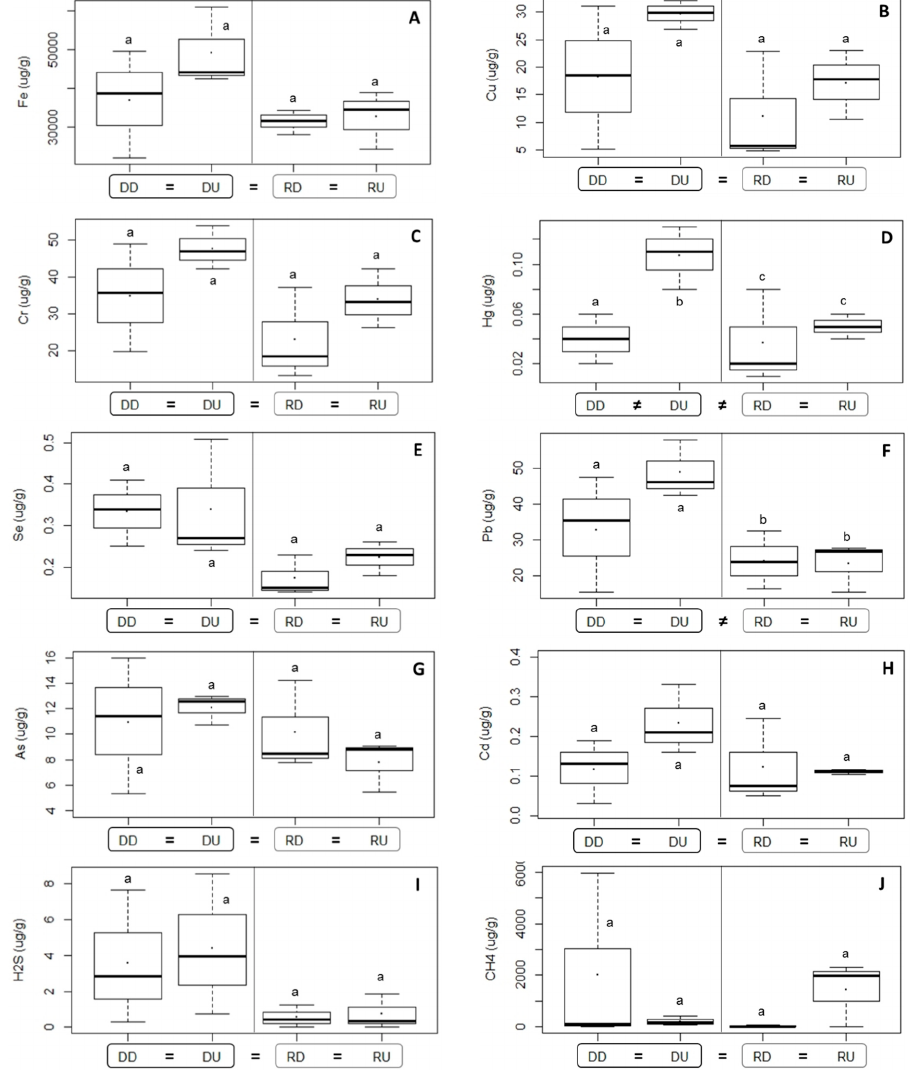
Figure 3. Box and whisker plots and mean values (.) for heavy metals including Fe ( A ), Cu ( B ), Cr ( C ), Hg ( D ), Se ( E ), Pb ( F ), As ( G ), Cd ( H ), H 2 S ( I ) and CH 4 ( J ) concentration in sediment of the estuarine sections. point to estuary level. Abbreviations: “DD” = dammed downstream, “DU” = dammed upstream, “RD” = reference downstream, “RU” = reference upstream. Letters a, b and c refer to signi fi cant di ff erences. “ ≠ ” sign indicated for the significant differences between 2 estuaries or/and estuarine sections within an estuary, while “=” sign meant that no significant difference was